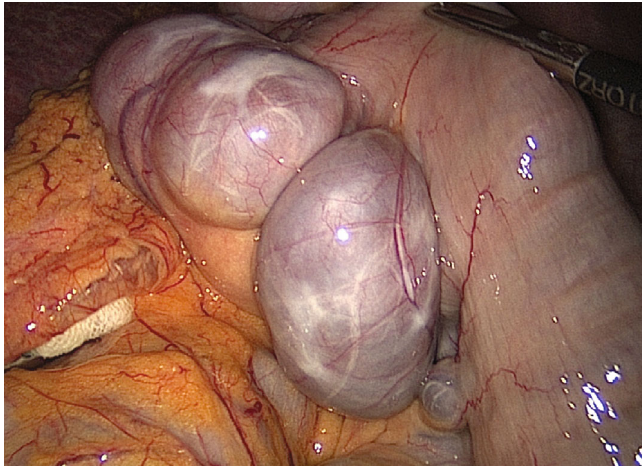
Figure 3: Intraoperative laparoscopic image of the extensive jejunal diverticulosis.